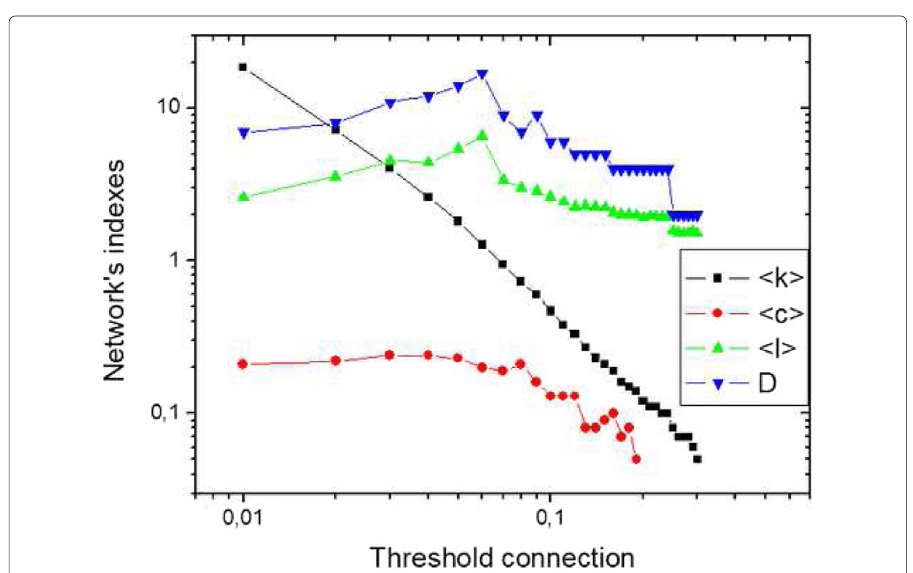
Fig. 3 Topological properties for different threshold connection. Log-log plot, base